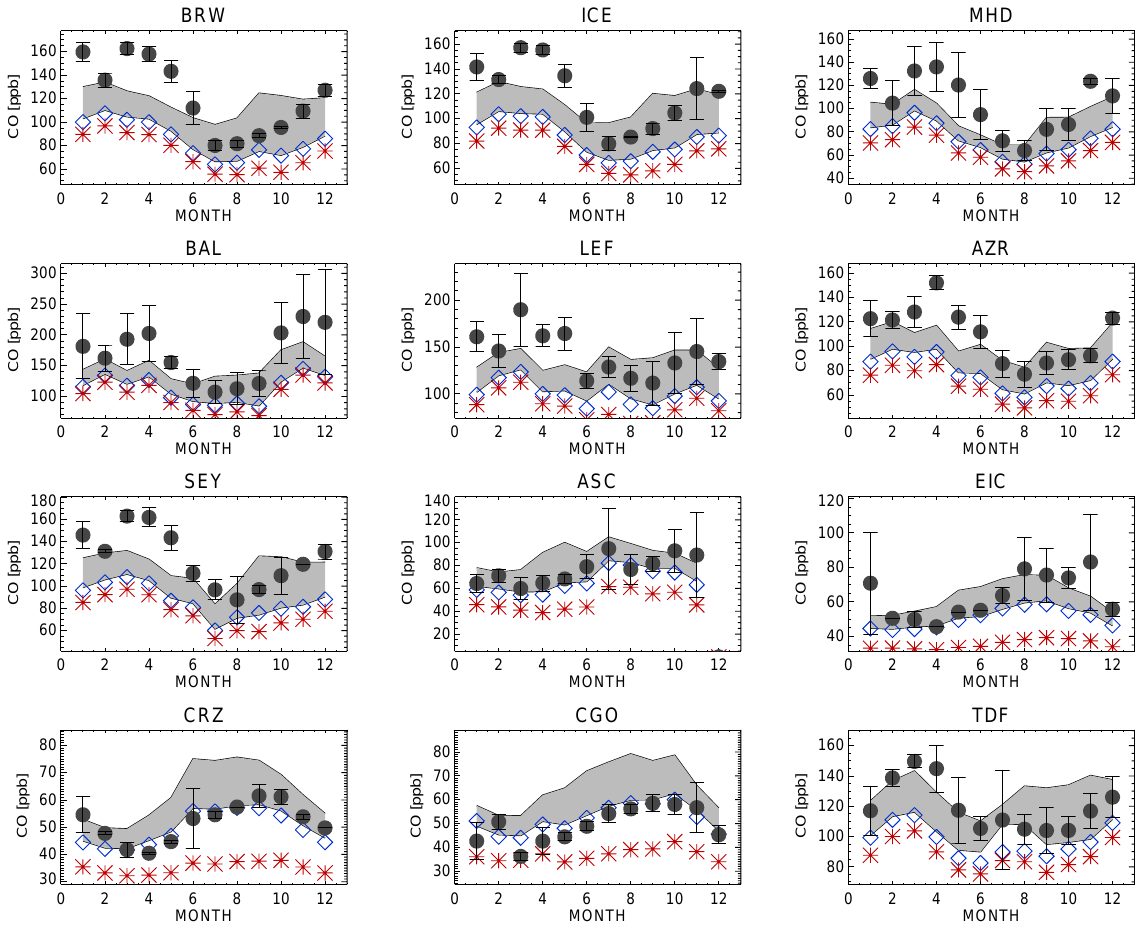
Fig. 8. Comparisons of monthly mean CO mixing ratios observed at various measurement sites from the GMD ground-based monitoring network (black filled circles and error bars), along with the 1- σ variability in the ensemble mean (shaded grey band) and the corresponding monthly means from the NOBVOC (blue squares) and NOISOPTERP (red asterisks) simulations. The stations shown are (top left to bottom right) Barrow, Canada (BRW, 71.3 ◦ N, 156.6 ◦ W), Sorhofi, Iceland (ICE, 63.3 ◦ N, 20.3 ◦ W), Mace Head, Ireland (MHD, 53.3 ◦ N, 9.9 ◦ W), Baltic Sea (BAL, 55.4 ◦ N, 17.1 ◦ E), Park Falls, USA (LEF, 45.9 ◦ N, 90.3 ◦ W), Azore Islands (AZR, 38.8 ◦ N, 27.4 ◦ W), Seychelles (SEY, 4.7 ◦ S, 55.2 ◦ E), Ascension Island (ASC, 7.9 ◦ S, 14.4 ◦ W), Easter Island (EIC, 27.2 ◦ S, 109.5 ◦ W), Crozet Island (CRZ, 46.5 ◦ S, 51.9 ◦ E), Cape Grim, Tasmania (CGO, 40.7 ◦ S, 144.7 ◦ E) and Tierra Del Fuego, Argentina (TDF, 54.9 ◦ S, 68.5 ◦